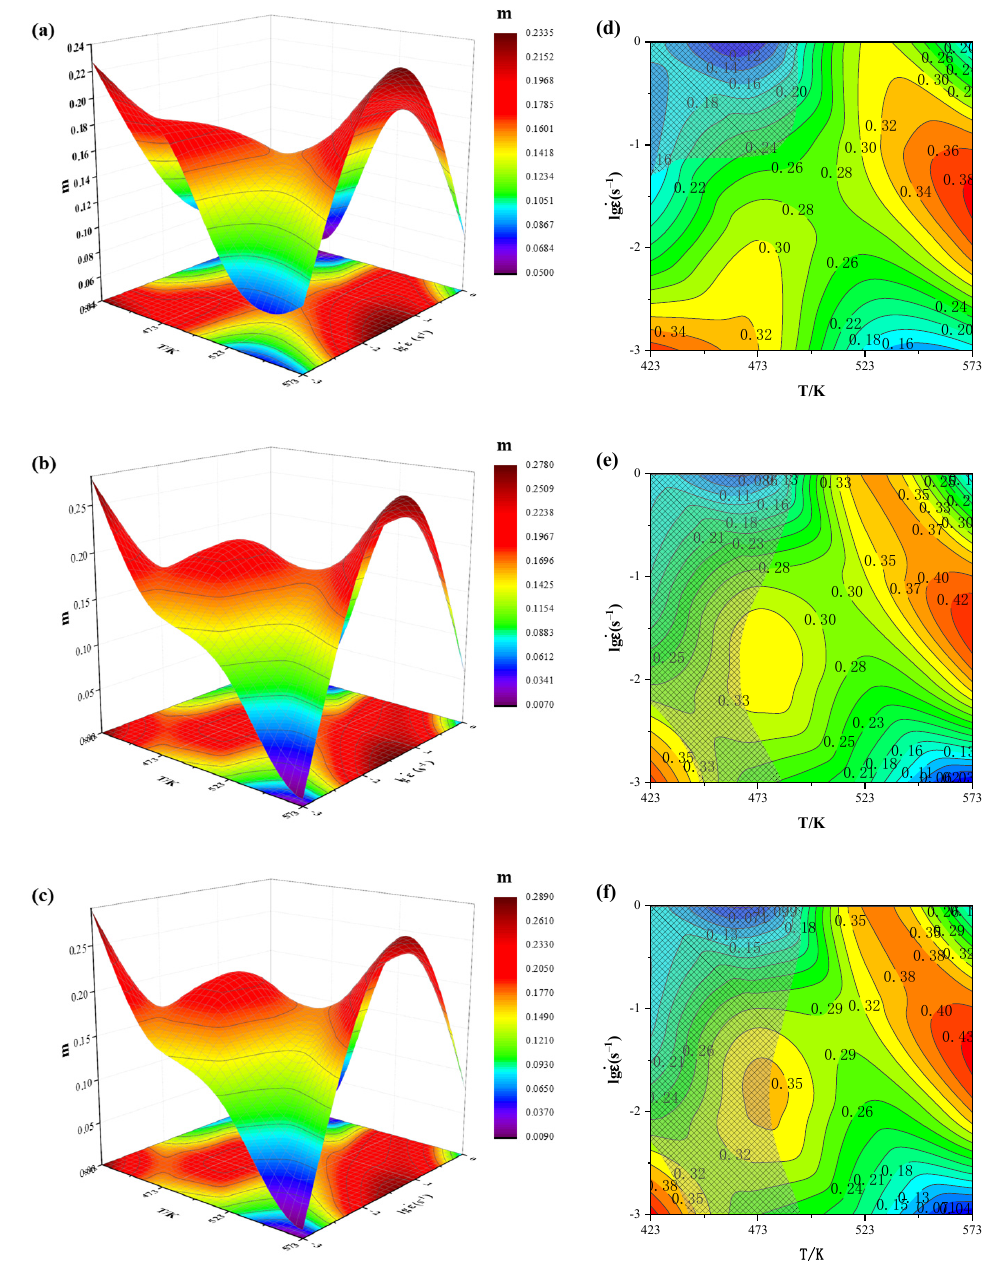
Figure 10. 3-D trend graph of m values (strain rate sensitivity exponent) and hot processing maps. ( a , d ) ε = 0.1, ( b , e ) ε = 0.3, ( c , f ) ε = 0.5. To sum up, according to Figure 10d–f, the processing safety zone and power dissipa- tion peak distribution of Mg-6Li alloy vary with the strain values, the hot working process should avoid the rheological instability area at first, and give priority to the dynamic recrystallization area, which is due to the good plasticity and easy control of microstructure and properties in the dynamic recrystallization area. Thus, the best processing safety zone should be selected at the deformation temperature of 500 K–573 K, and the strain rate between 0.01 s − 1 and 0.1 s − 1 , because the rheological resistance of the alloy is small and there is no plastic instability, which could provide a good reference for the process parameter selection of hot extrusion and hot rolling experiments to be carried out